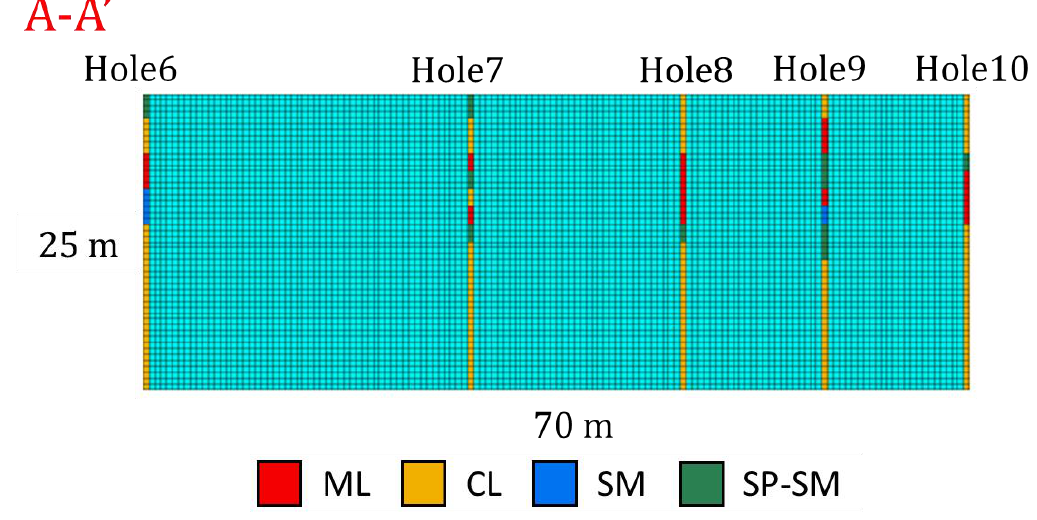
Figure 5. Schematic of the drilling locations at a construction site in northern Taiwan.